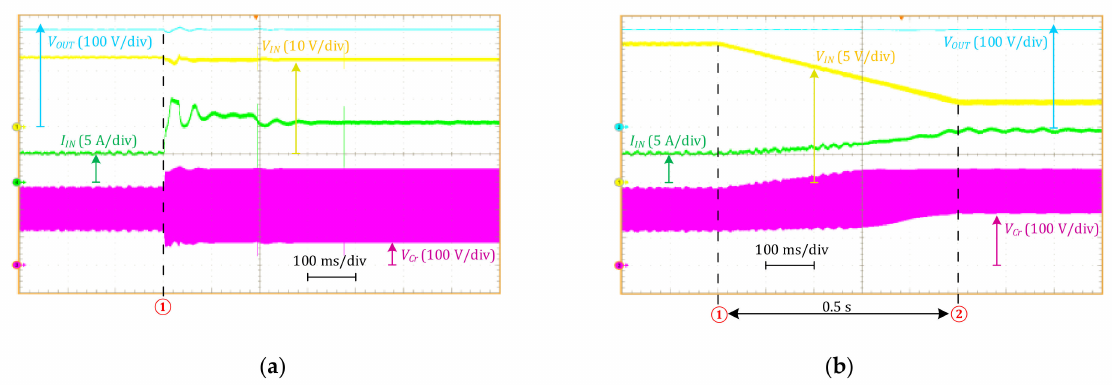
Figure 22. The converter response to ( a ) load step change and ( b ) the input voltage